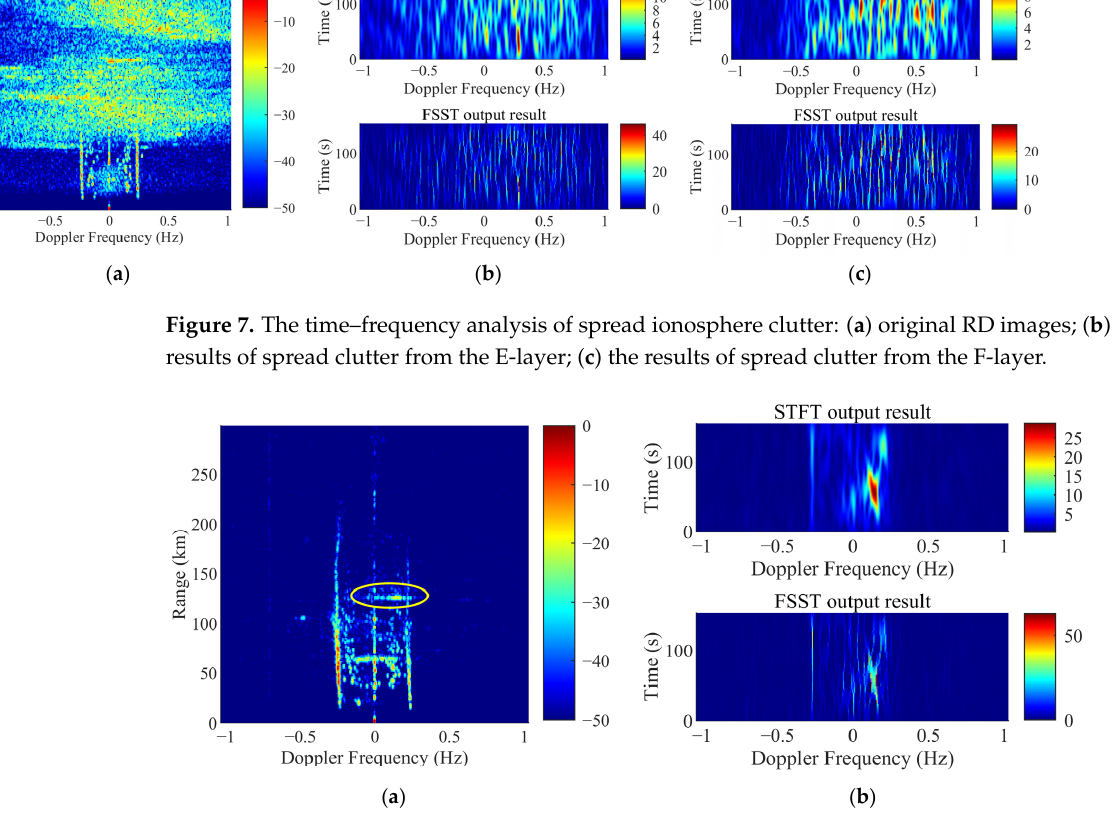
Figure 8. The time–frequency analysis of uneven ionosphere clutter: ( a ) original RD images; ( b ) the results of uneven ionosphere clutter. According to the long-term observations, some range cells are usually contaminated,